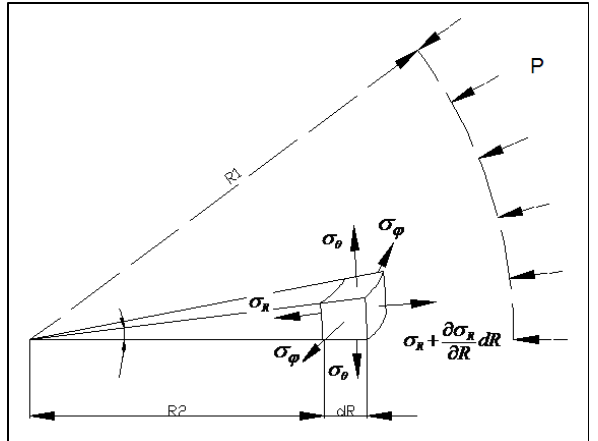
Figure 3. Free body diagram under spherical coordinate